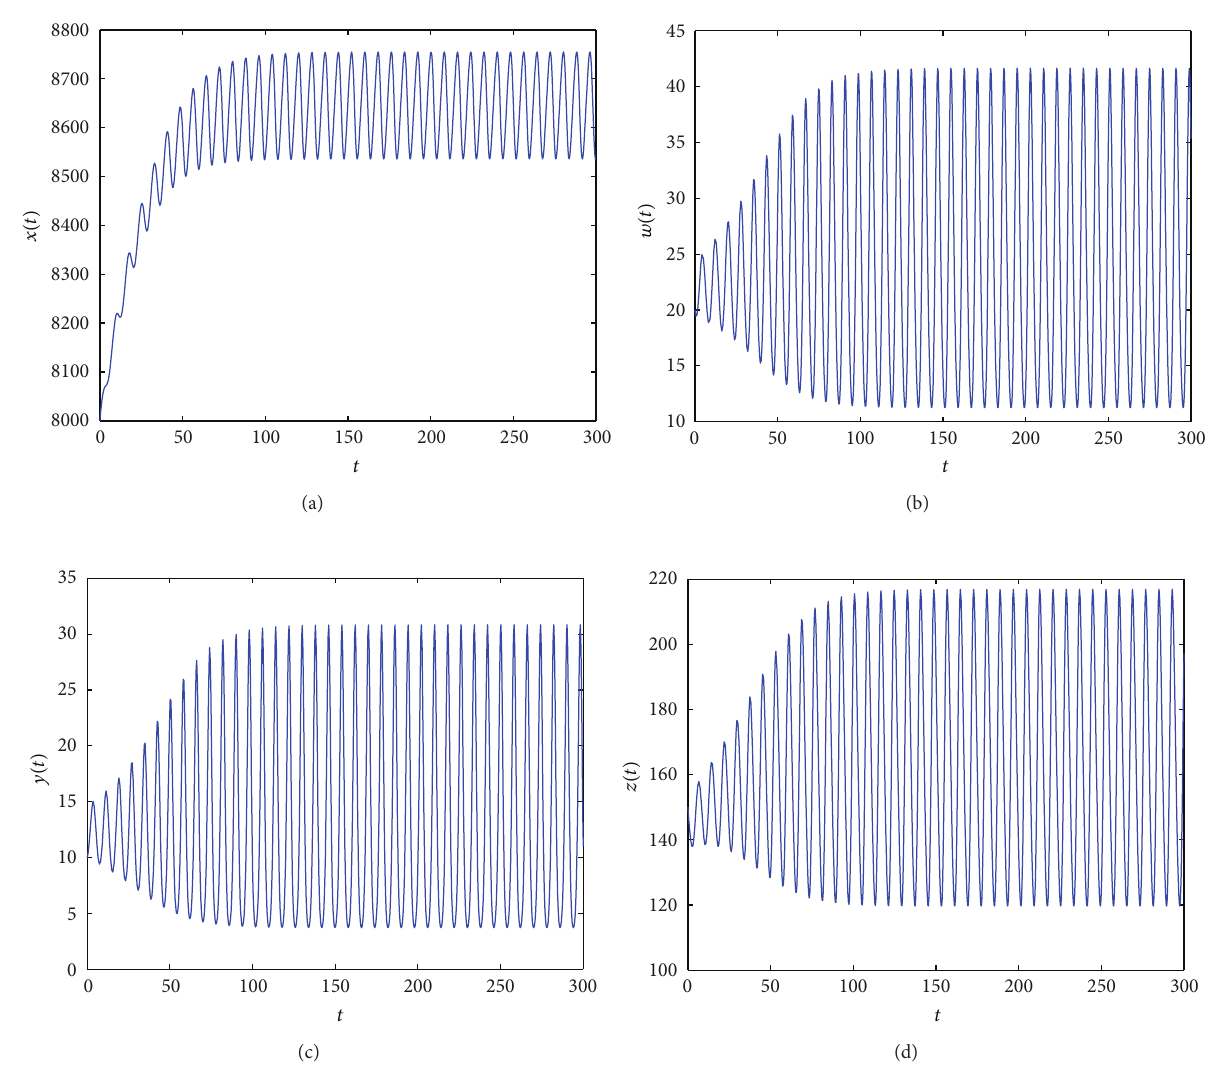
Figure 2: When 𝜏 = 1.2 > 𝜏 0 , the CTL-activated infection equilibrium 𝐸 ∗ (8790.7081, 23.5465, 12.0000, 161.5044) of system (2) becomes